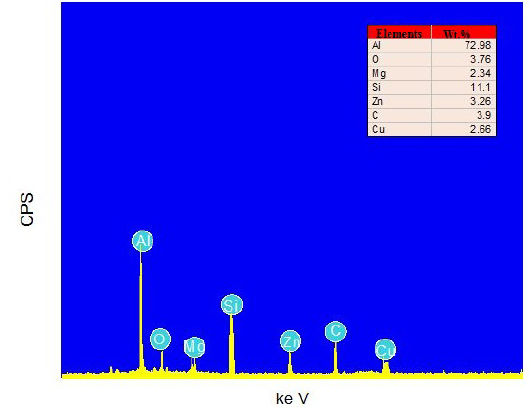
Figure 2. Energy dispersive X-Ray (EDX) profile of AA7075 with 15 wt %